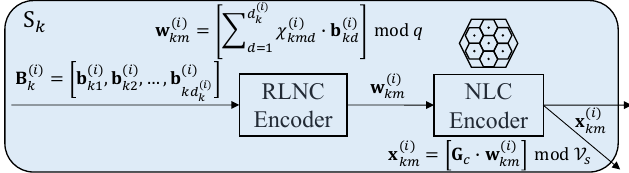
Figure 3. Encoding process at source k for chunk i . RLNC, random linear network coding.